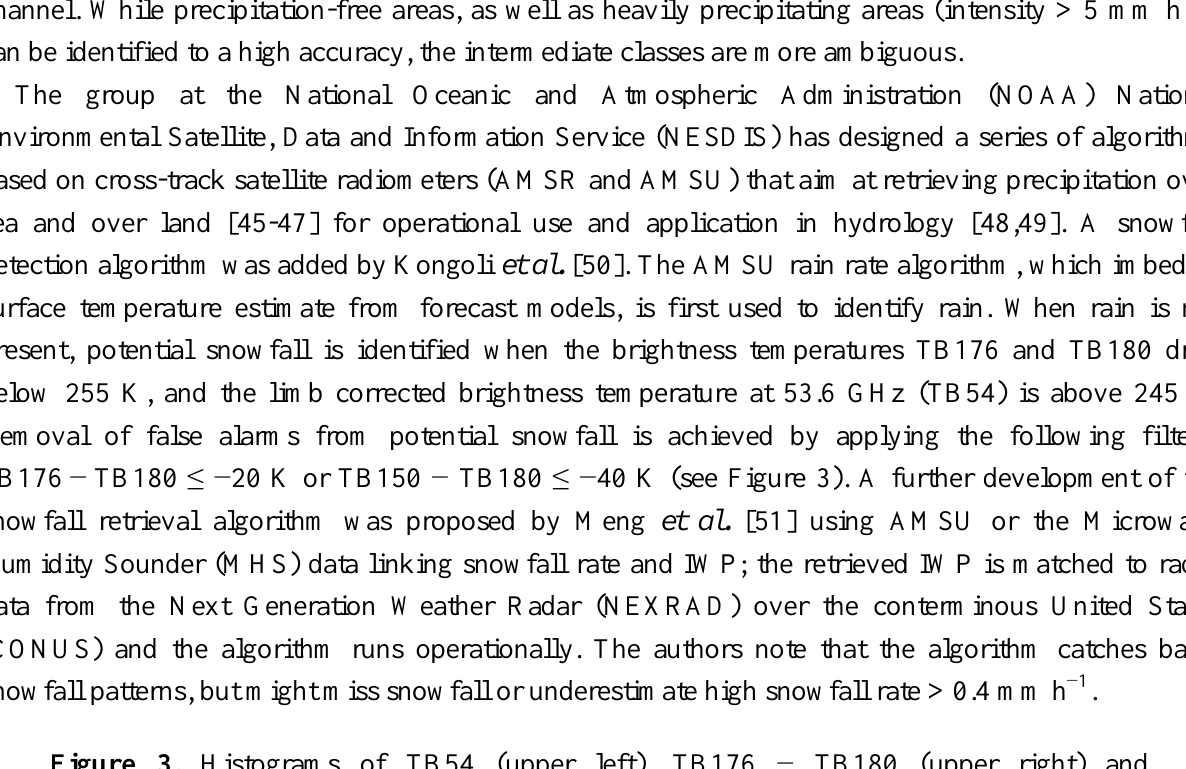
Figure 3. Histograms of TB54 (upper left), TB176 − TB180 (upper right) and TB150 − TB180 (lower left), and filtered scatter plot of TB176 and TB180 (lower right) from Kongoli et al. [50]. [Courtesy of the American Geophysical